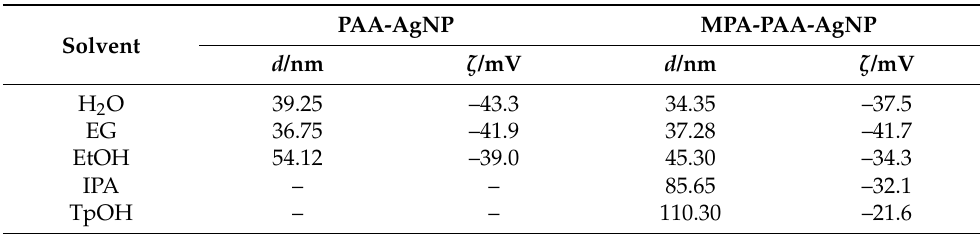
Table 1. Average particle diameter and corresponding zeta-potential values for PAA-AgNPs and MPA-PAA-AgNPs in simple